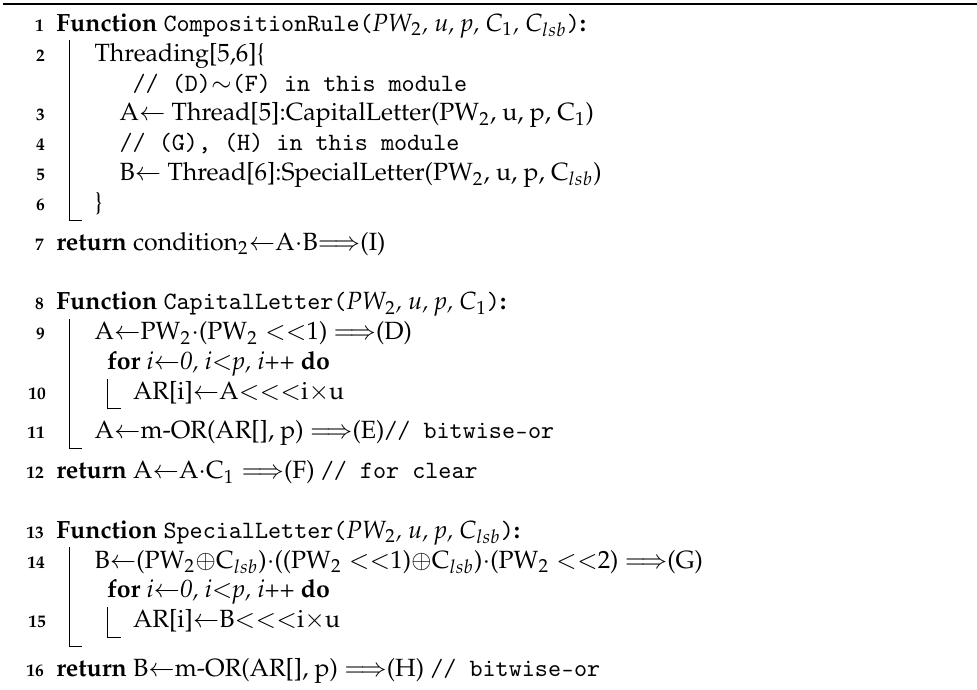
Algorithm 4: Pseudo-code of CompositionRuleChecker().